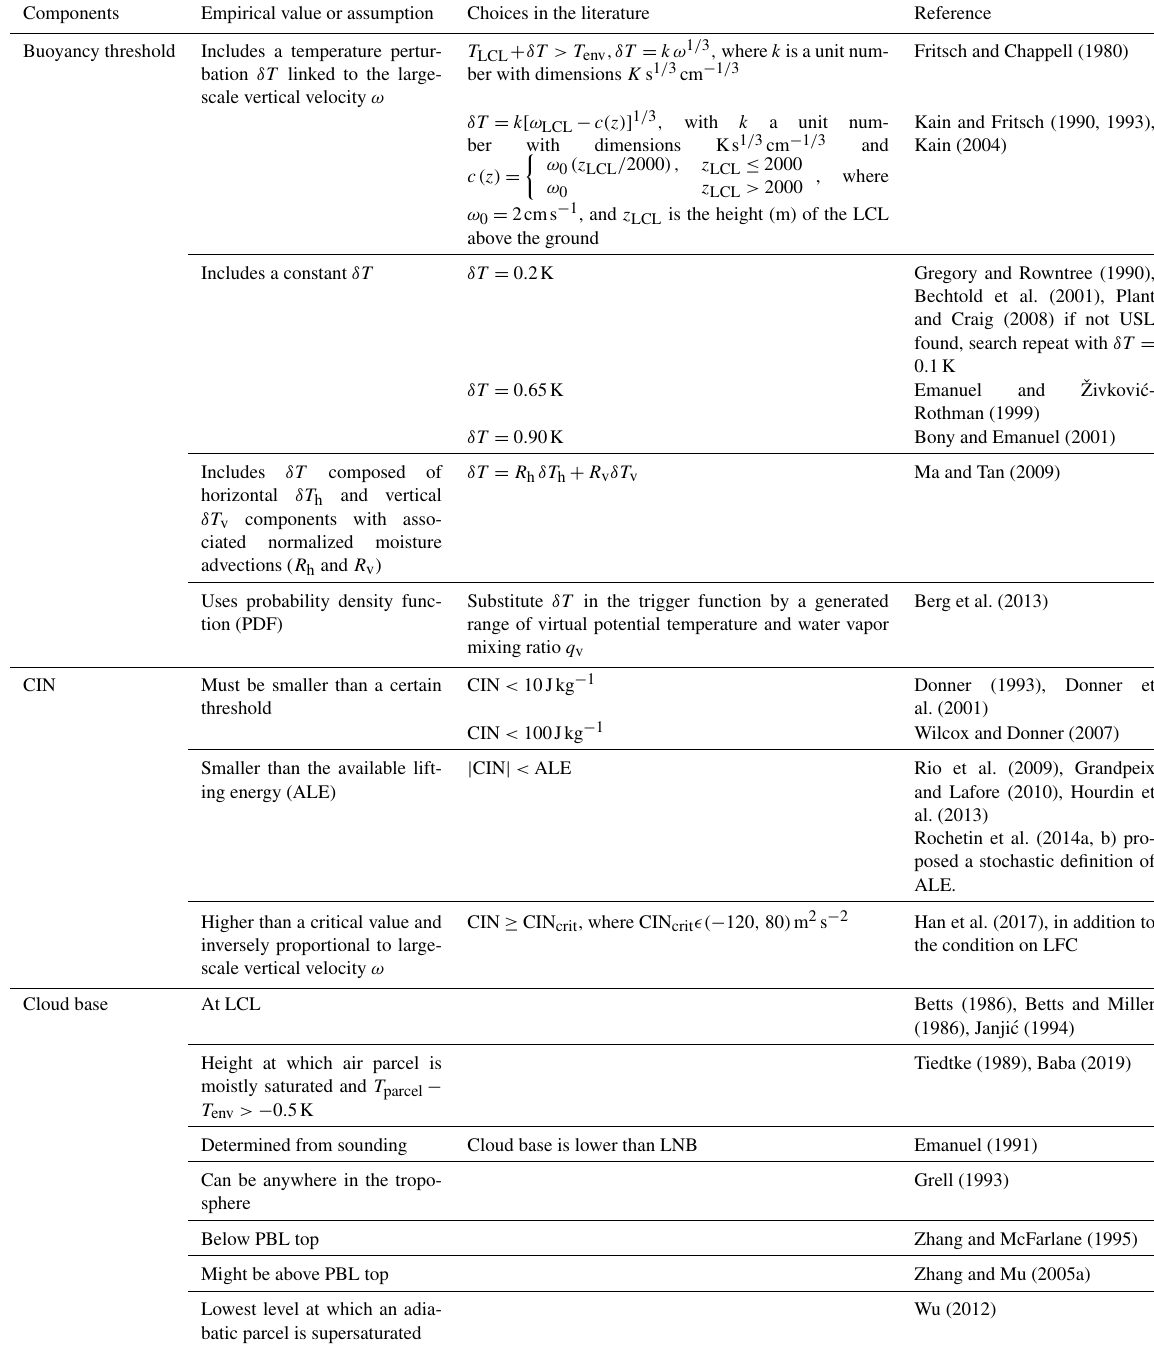
Table 3. A sample of empirical values and assumptions used in the trigger (note: subscript “sh” refers to shallow convection).